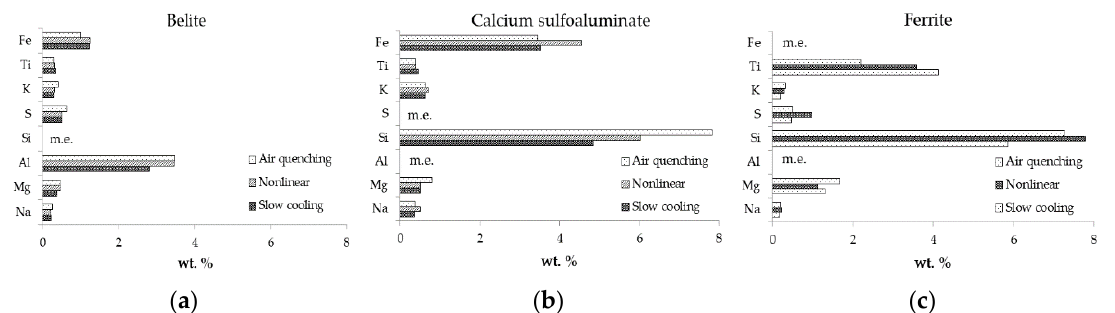
Figure 7. Distribution of substitute elements in the main clinker phases (m.e.: Major element making up the basic lattice of the phase). ( a ) belite.; ( b ) Calcium sulfoaluminate; ( c ) Ferrite.